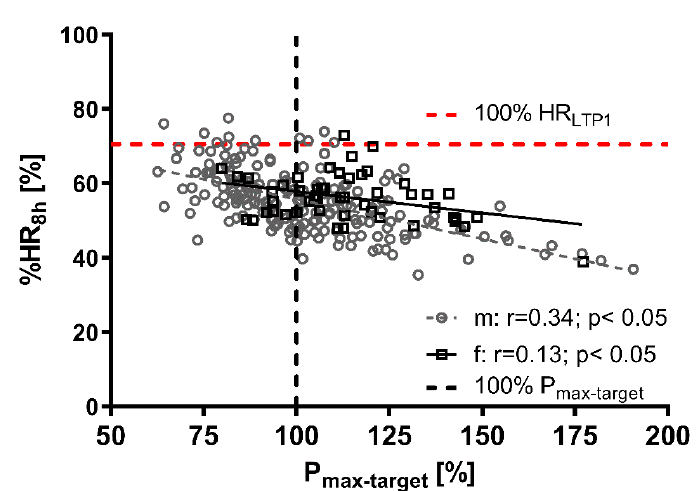
Figure 3. Correlation between the maximum power output (P max ) related to the target standard P max (P max-target ) and percentage of maximum heart rate (% HR 8 h ) during 8 h occupational work for male (m) and female (f) workers. Dotted lines represent age-predicted maximum target cycle ergometer power output (black) and heart rate at the first lactate turn point (LTP 1 , red).